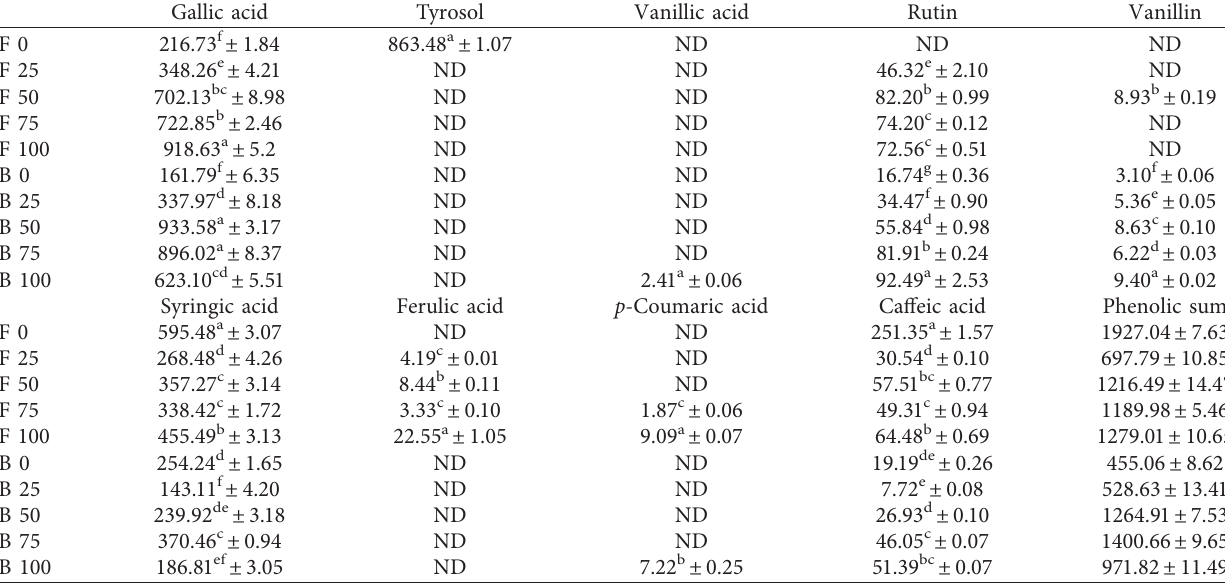
Table 4: Content of individual polyphenol compounds of 17 flour samples and composite biscuits determined by HPLC-DAD (mg/100g DW).